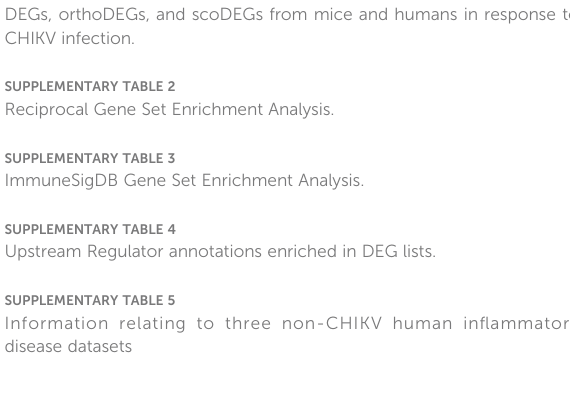
SUPPLEMENTARY TABLE 2 Reciprocal Gene Set Enrichment Analysis. SUPPLEMENTARY TABLE 3 ImmuneSigDB Gene Set Enrichment Analysis. SUPPLEMENTARY TABLE 4 Upstream Regulator annotations enriched in DEG